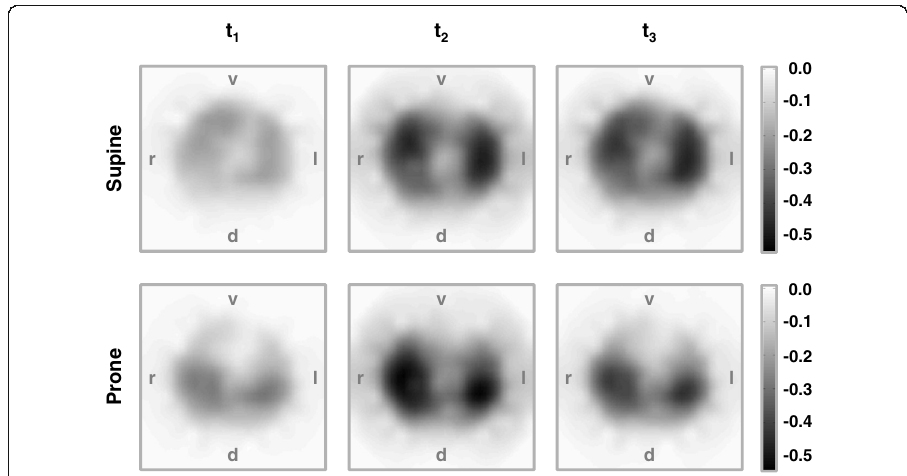
Fig. 2 Example functional EIT images. The images show the regional fall in electrical bioimpedance in lung areas in one of the examined animals in the supine (top) and the prone positions (bottom) at three time points during the bronchoalveolar lavage procedure. The impedance decrease is shown in dark tones after the disconnection of the endotracheal tube from the ventilator before the fluid instillation ( t 1 ), after the fluid instillation ( t 2 ) and after the fluid suction before the resumption of ventilation ( t 3 ) in each case relative to baseline. v, ventral; d, dorsal; r, right; l, left